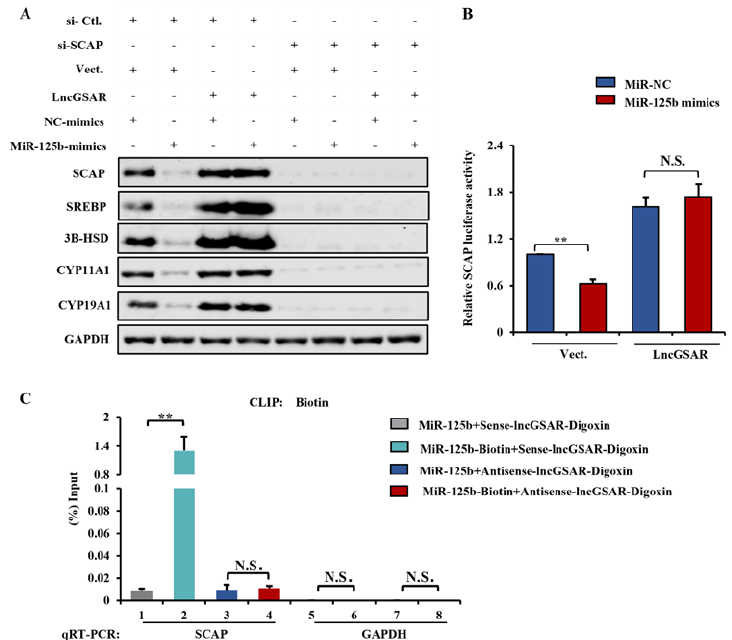
Figure 8. LncGSAR functions as a ceRNA to regulate SCAP-SREBP pathway by sponging MiR-125b, thus promoting GCs proliferation and steroidogenesis. ( A ) Western blot detection of steroidogenesis-related and sterol regulatory element proteins. ( B ) Dual-luciferase reporter demonstrated the binding relationship among lncGSAR, MiR-125b and SCAP. ( C ) The interactions of lncGSAR with MiR-125b and MiR-125b with SCAP were determined by RNA-RNA interaction pull-down assay. Values represent means ± SEM for three individuals. ** p < 0.01. N.S., not significant. To further explore whether lncGSAR affects the binding of MiR-125b to its target SCAP, we labeled MiR-125b and lncGSAR with biotin and digoxigenin, respectively, as well as performed RNA-RNA binding assays. We found that biotin-labeled MiR-125b was associated with SCAP but not unlabeled MiR-125b. Furthermore, digoxigenin-labeled- sense-lncGSAR disrupted the binding between MiR-125b and SCAP but not for the di- goxigenin-labeled antisense lncGSAR (Figure 8C). Taken together, all the results support the idea that lncGSAR acts as an MiR-125b sponge to protect the SCAP from the attack of MiR-125b, thereby promoting cell proliferation and E 2 secretion and inhibiting P 4 secre- tion. 3. Discussion Ovarian follicular development is a highly coordinated and nutrition-sensitive pro- cess [23], and glucose is an important energy substrate for metabolism in the follicles of many species [24 – 27]. Previous studies confirm that short-term dietary supplementation of ewes during the luteal phase can increase fertility due to elevated glucose and steroid hormone concentrations in follicles [19,28,29], whereas glucose has deleterious effects on ovary structure and function at higher concentrations [5,30,31]. Our previous study also demonstrated that glucose dose had a significant effect on GCs function, with 8.4 mM representing the optimal glucose concentration for GCs to secrete steroid hormones in vitro and a higher concentration of glucose (33.6 mM) inhibiting GCs proliferation and steroidogenesis [6,7]. Therefore, there is a potential regulatory relationship between